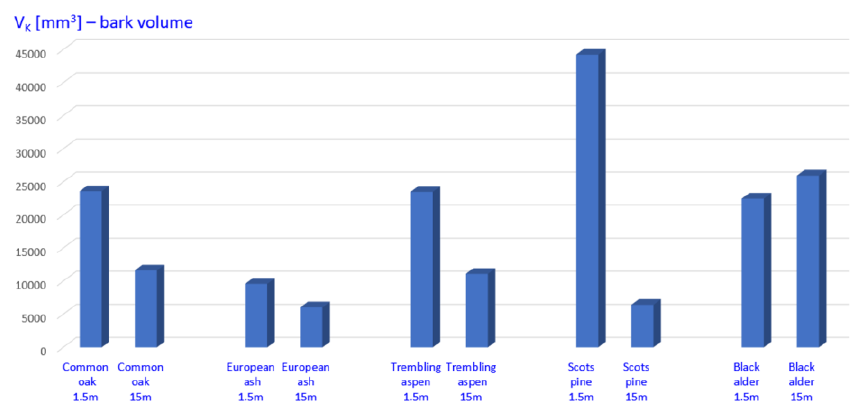
Figure 11. Volume V K (mm 3 ) calculated for the space between the bark surface and the reference surface for a measurement area of 180 × 120 mm.